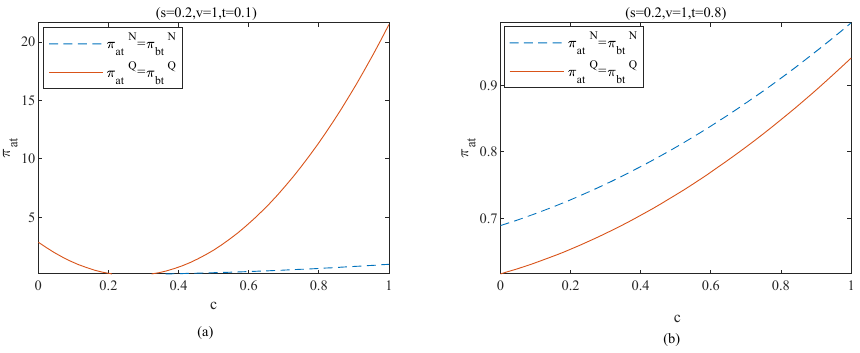
Figure 5. Platform’s total profit in equilibrium ( t = 0.1 vs. t = 0.8). Proposition 5 also shows that, when the market competition is strong, with the in- crease of users’ privacy cost, the revenue from quality discrimination is always lower than that without quality discrimination. This is because, as shown in Figure 4, the uniform quality set by platforms for all users without quality discrimination is slightly higher than that set by firms for new and old users with quality discrimination. With the increase of users’ privacy cost, higher quality product can attract more users. Therefore, com- pared with adopting quality discrimination, platforms can obtain more profits without quality discrimination.